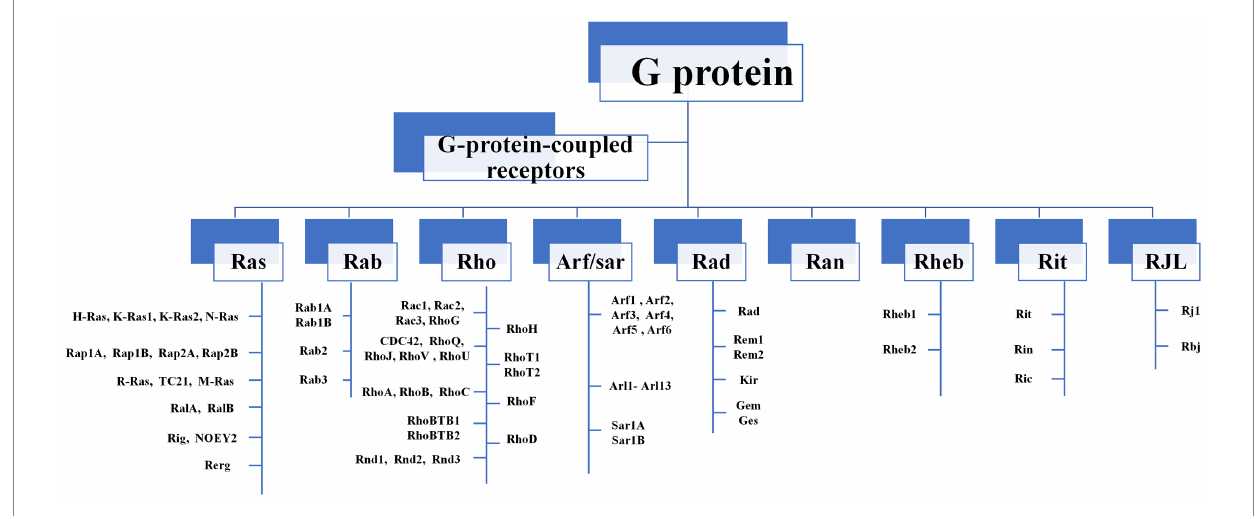
FIGURE 1 The composition of Ras-like superfamily. There are nine major subgroups in the Ras-like superfamily, including Ras, Rab, and Rho families. Rho GTPases can be divided into 9 subfamilies (Rac, Rho, RhoD, Cdc42, RhoH, RhoF, Rnd, Miro, RhoBTB) according to their structural and functional